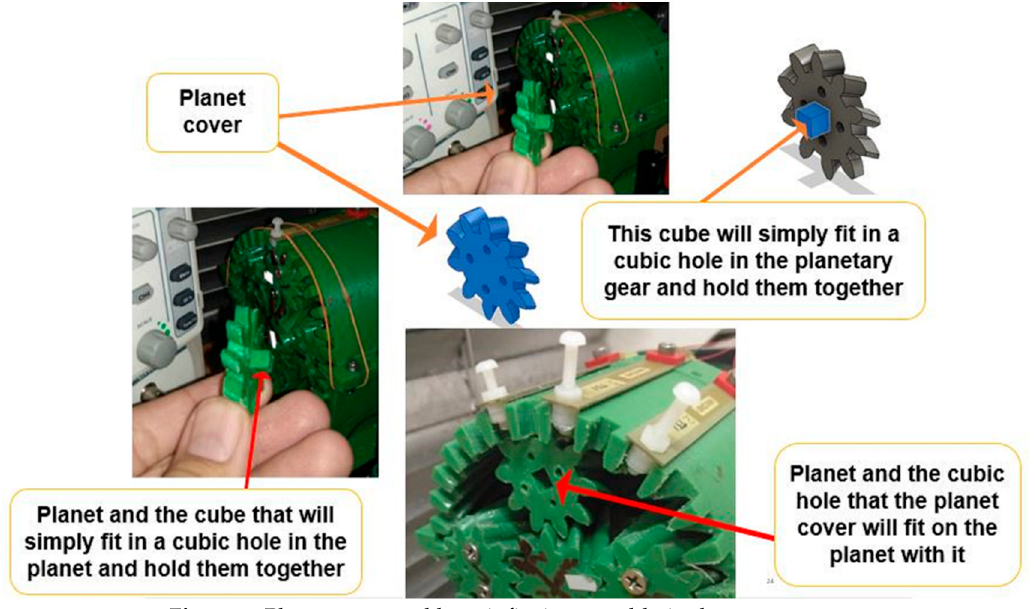
Figure 6. Planet cover and how it fits in smoothly in the prototype.